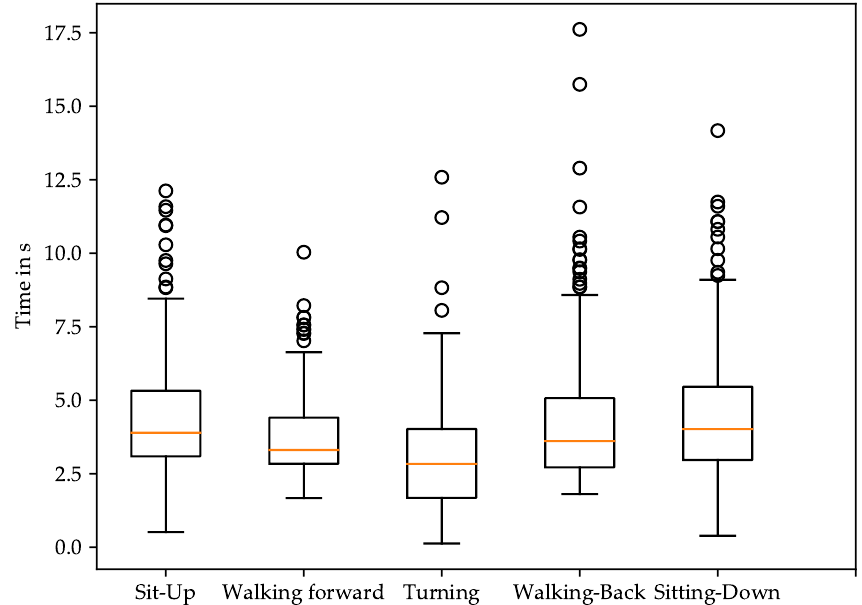
Figure 6. Distribution of Timed Up-and-Go test subtask times for all 23 participants. Scatter plots of the significant correlations are shown in Figure 7 for the muscles vastus medialis, biceps femoris, and gastrocnemius medialis.